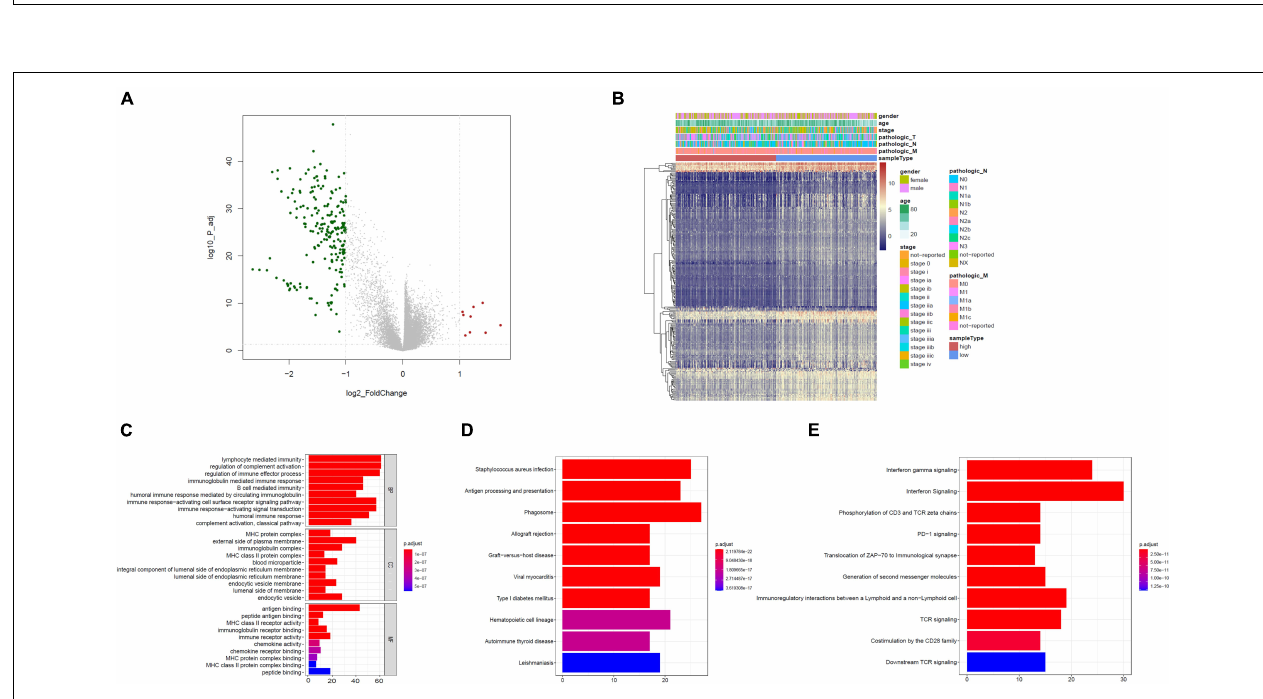
FIGURE 4 | Functional assessment. (A) Volcano plot illustrating DEGs between the high- and low-risk groups; red dots designate upregulated genes, green dots designate downregulated genes, and gray dots designate no difference genes. (B) Heat map of DEGs between high- and low-risk group. (C) Bar plot of Gene Ontology (GO): biological process (BP), GO: cellular component (CC), and GO: molecular function (MF). (D) The top 10 enriched KEGG pathway terms. (E) The top 10 enriched reactome cascade terms. The X-axis indicates the number of rich genes, and the Y-axis indicates the pathway. Bar colors represent p -values.